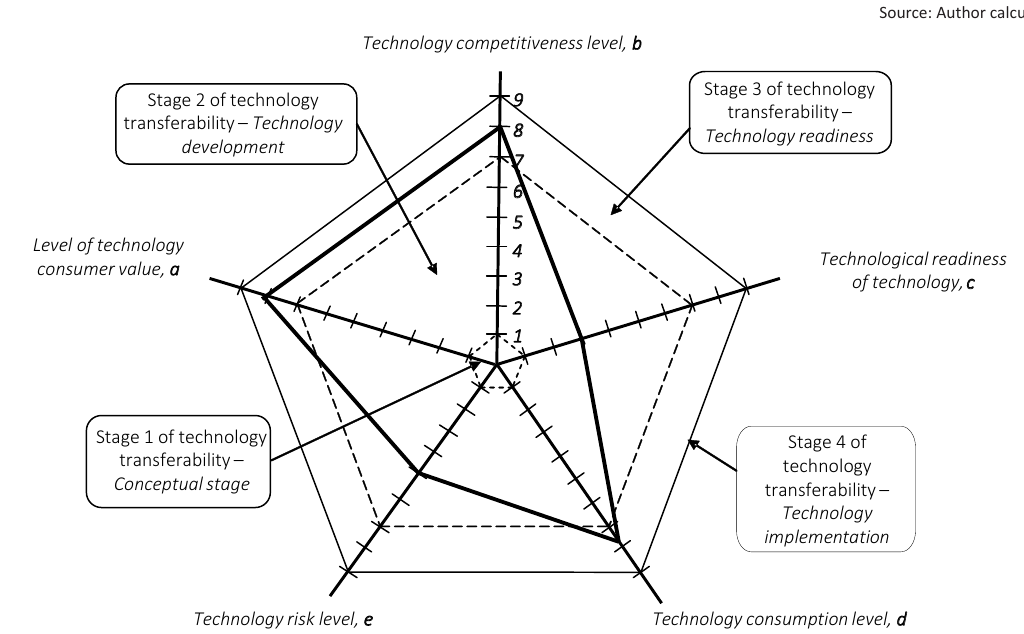
Figure 2. Determining the polygon for the technology transferability level of OSL dosimetry